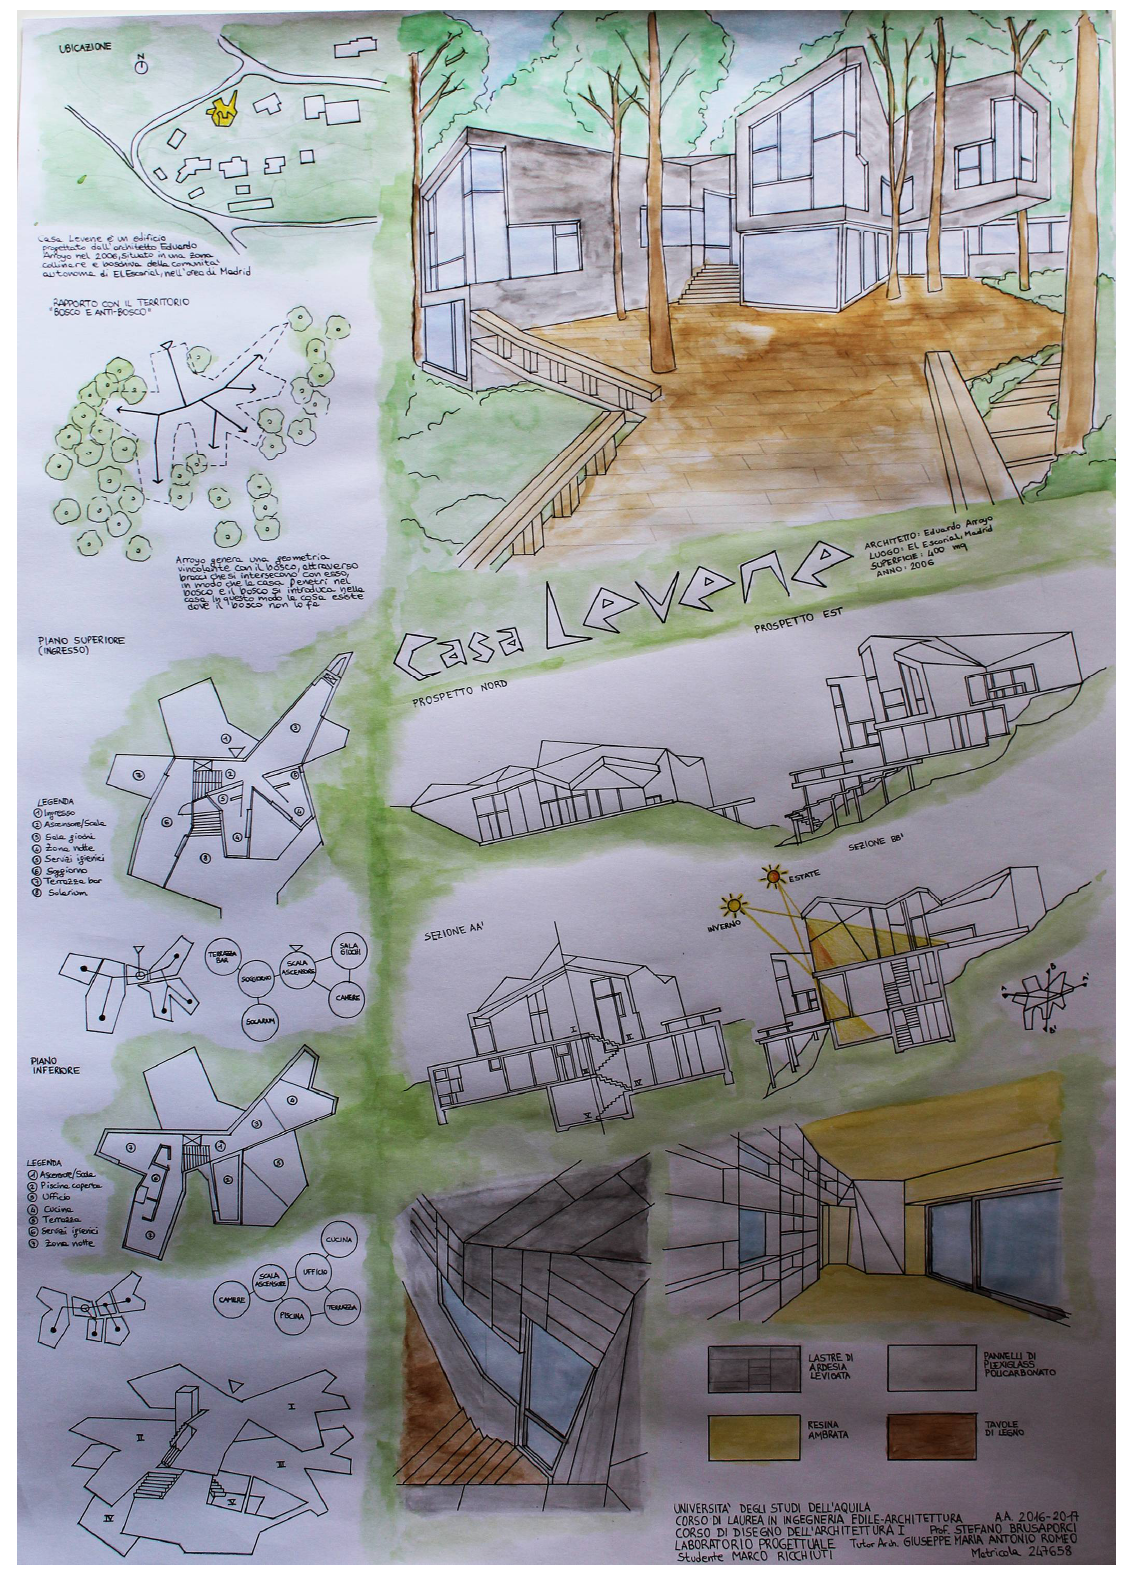
Figure 5. Graphical analysis. Study of Levene_House Eduardo Arroyo, San Lorenzo de El Escorial, Madridn (student Marco